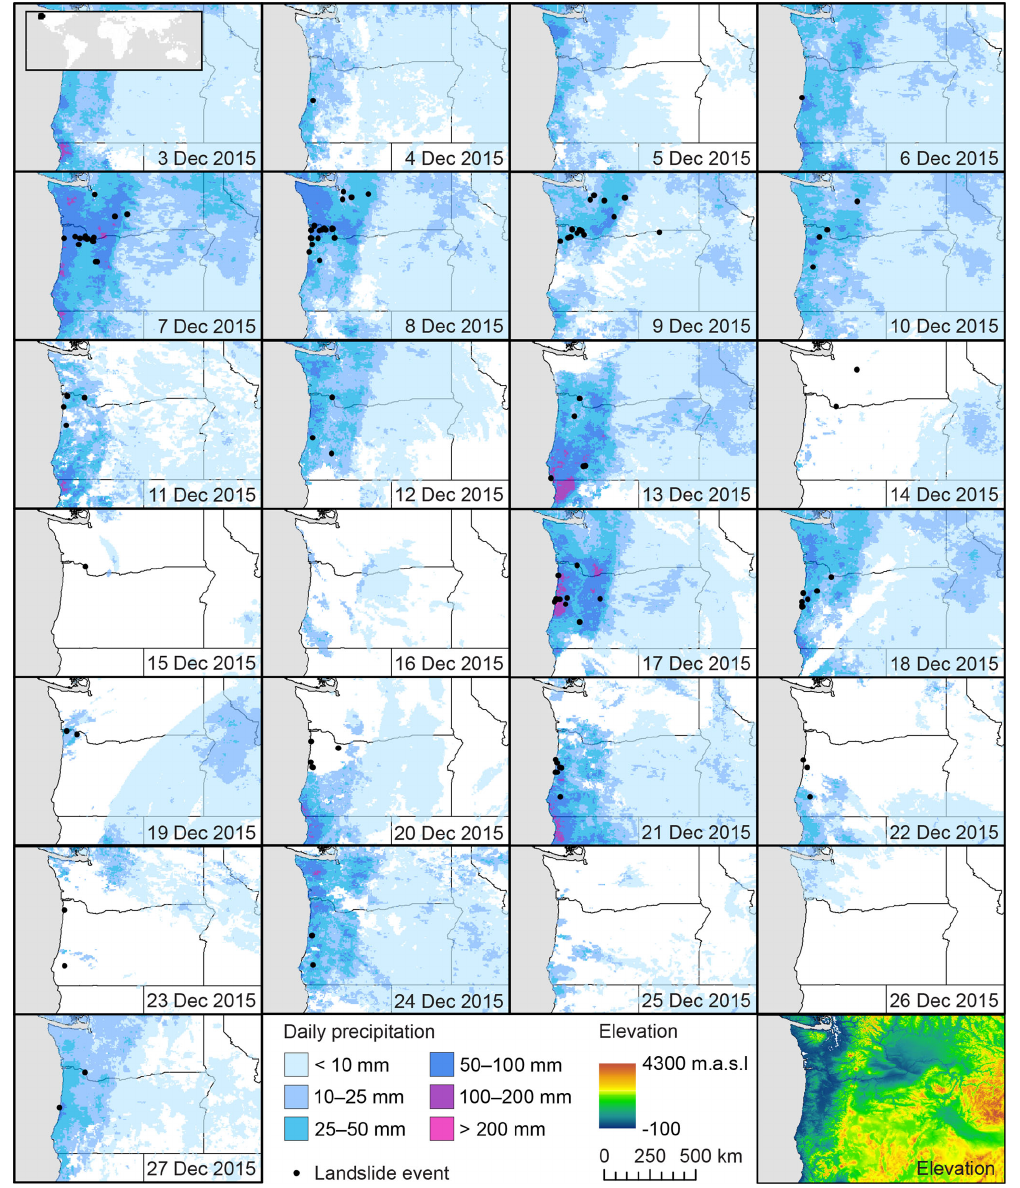
Figure 8. Location and time series of the longest cluster, located mainly in Oregon, US. Also shown are daily rainfall and elevation. Elevation data are available from the US Geological Survey